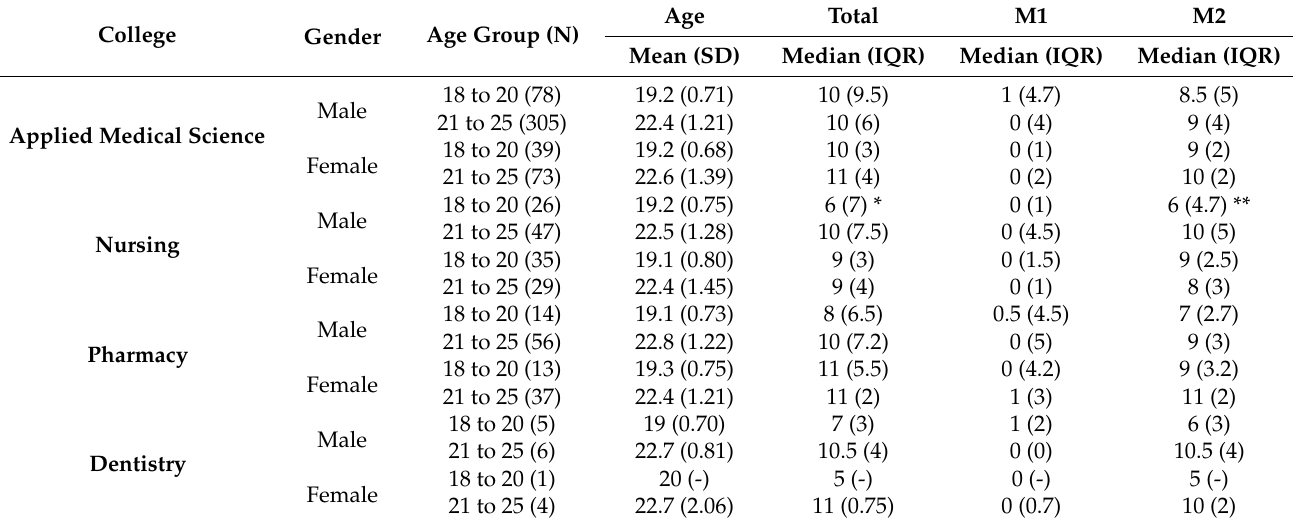
Table 2. Knowledge scores of various categories of students for IDA (M2), IDA causing male infertility (M1), and Total.